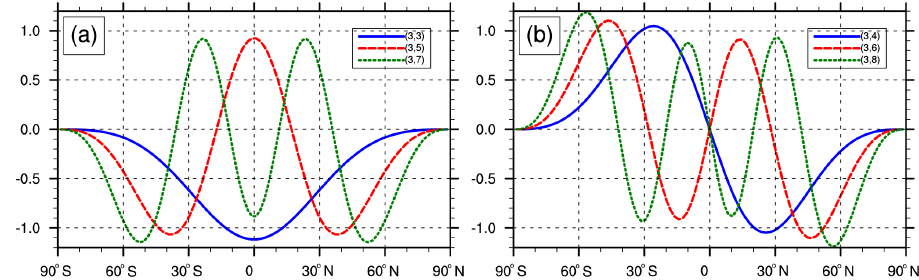
Figure 3. The first few symmetric and anti-symmetric Hough modes for TW3 ( s = 3, σ = 1 . 5) of scalar fields, computed using the normalized ALP expansions. The left panels are symmetric modes, and the right panels are anti-symmetric